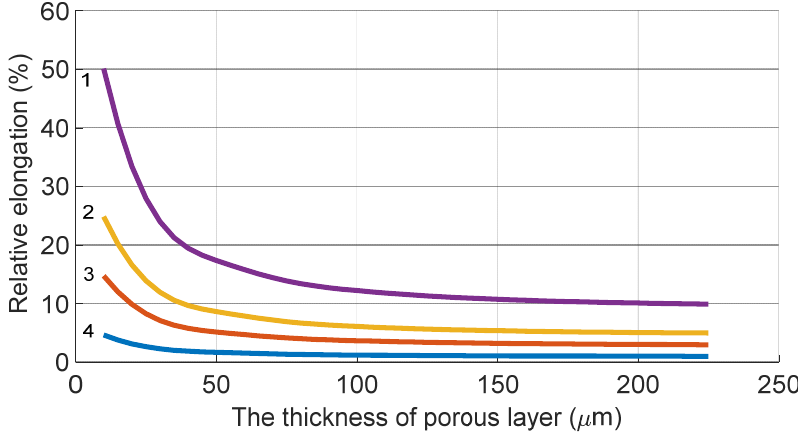
Figure 6. The relative elongation (𝜀) versus the thickness of the porous layer (ℎ) at various pressures in the high-pressure channel: 1—10 MPa, 2—5 MPa, 3—3 MPa, and 4—1 MPa.